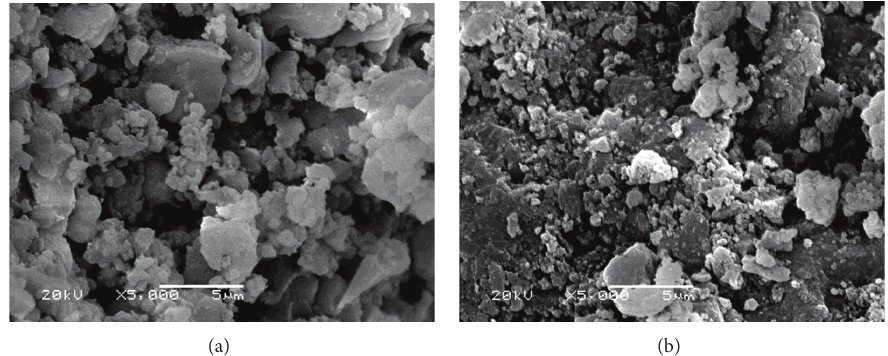
Figure 1: Micrographs obtained by SEM of the resulting xerogels: (a) Pd(0)/SiO 2 /HF and (b) Pd(0)/SiO 2 /HCl.